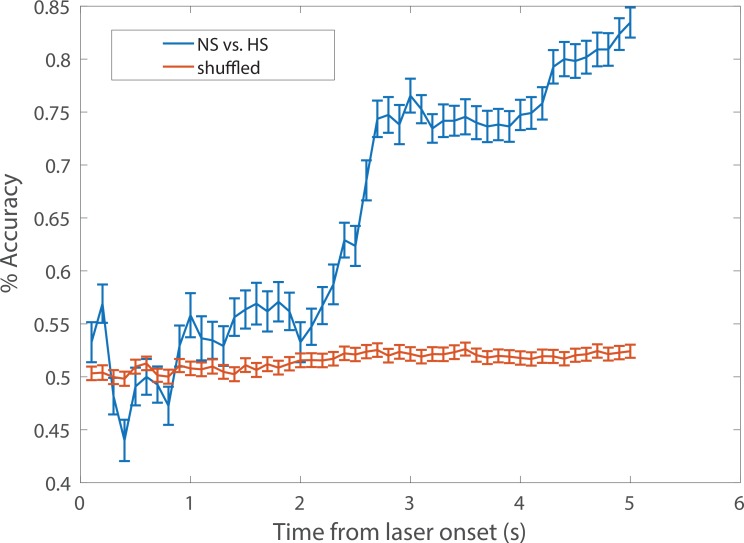
A representative example of cumulative decoding accuracy curves using the SVM classifier.Time zero denotes the laser onset. The blue curve denotes the decoding accuracy (n1 = 24 trials for NS, n2 = 32 trials for HS; C = 7 ACC neurons) derived from the data with true labels; the error bar denotes the SEM from 100 Monte Carlo simulations based on 5-fold cross-validation; the maximum decoding accuracy was 0.83. The red curve denotes the decoding accuracy derived from the shuffled data with randomly permuted labels; the error bar denotes the SEM from 500 random permutations; the maximum decoding accuracy was 0.53. The chance level 53% (instead of 50%) was partially due to the imbalance of the sample size (n1≠ n2). See Materials and methods for details.